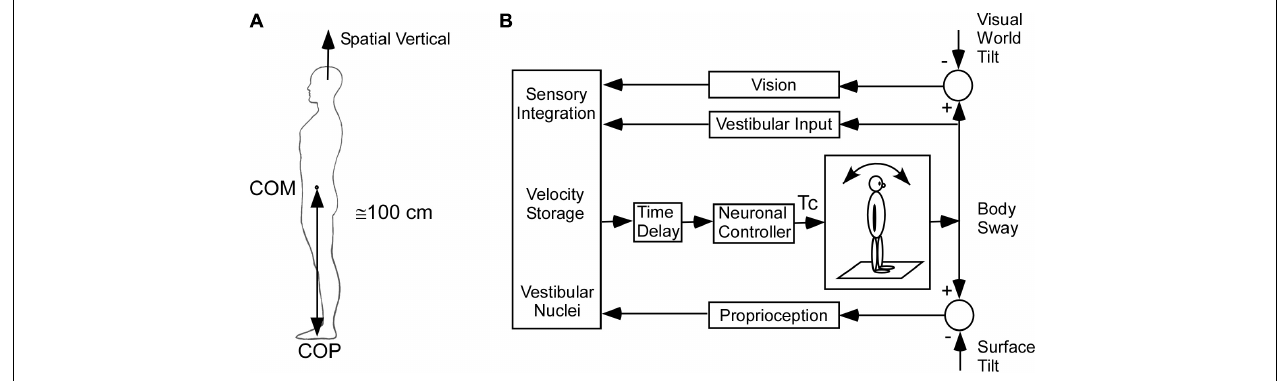
FIGURE 2 | Model of the postural control. (A) Inverted pendulum model. COM – center of mass, COP – center of pressure. (B) Model of sensory integration of visual, vestibular, and proprioceptive inputs [modified from Horak (2009)]. This model includes the low frequency postural adjustments contributed by velocity